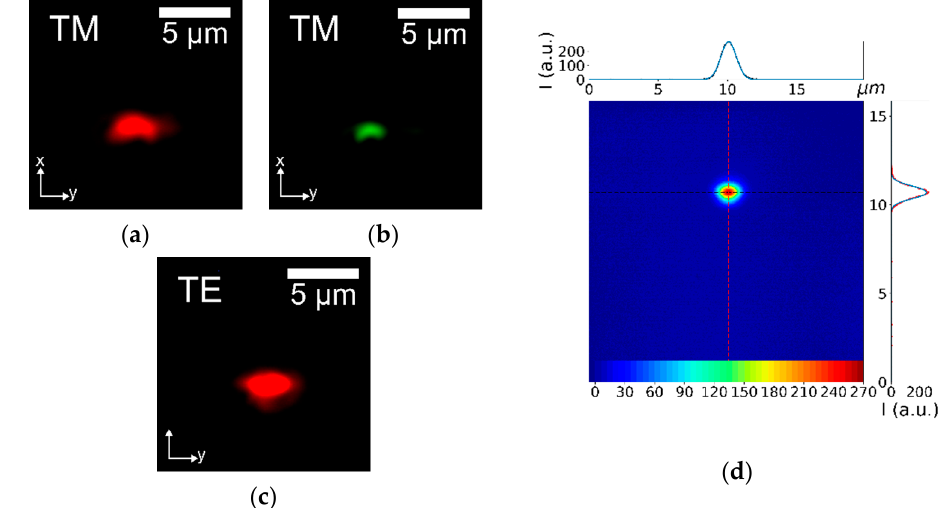
Figure 4. Examples of near-field CCD images of the output of the Ti-undiffused waveguide excited with different light sources. ( a , b ) report the output of a waveguide which is coupled with a laser beam at 632.8 and 533 nm, respectively. Both the first two figures represent Transverse Magnetic (TM) propagation modes, whereas ( c ) refers to the same waveguide of ( a ), but supporting a Transverse Electric (TE) propagation mode. ( d ) Beam profiling analysis of the output light from a waveguide excited by a laser beam in TM polarization at 632.8 nm. The gaussian profiles on the top and on the right represent the intensity profile of the outcoming beam along the y-axis and the x-axis of the LN device,